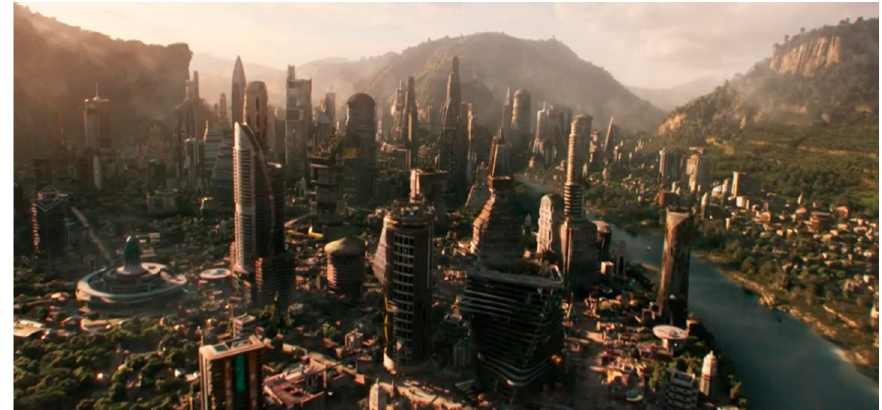
Figure 1. Aerial shot of Wakanda (Taken in accordance with fair use of images rights for the film Black Panther , Ryan Coogler, 2018, Marvel).